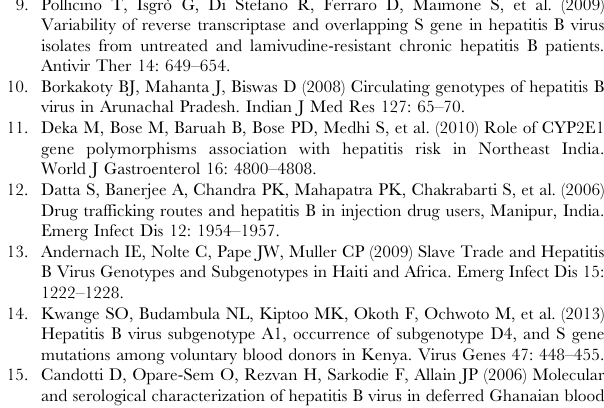
origin of 15 full length sequences of HBV of subgenotype D4 available prior to the present